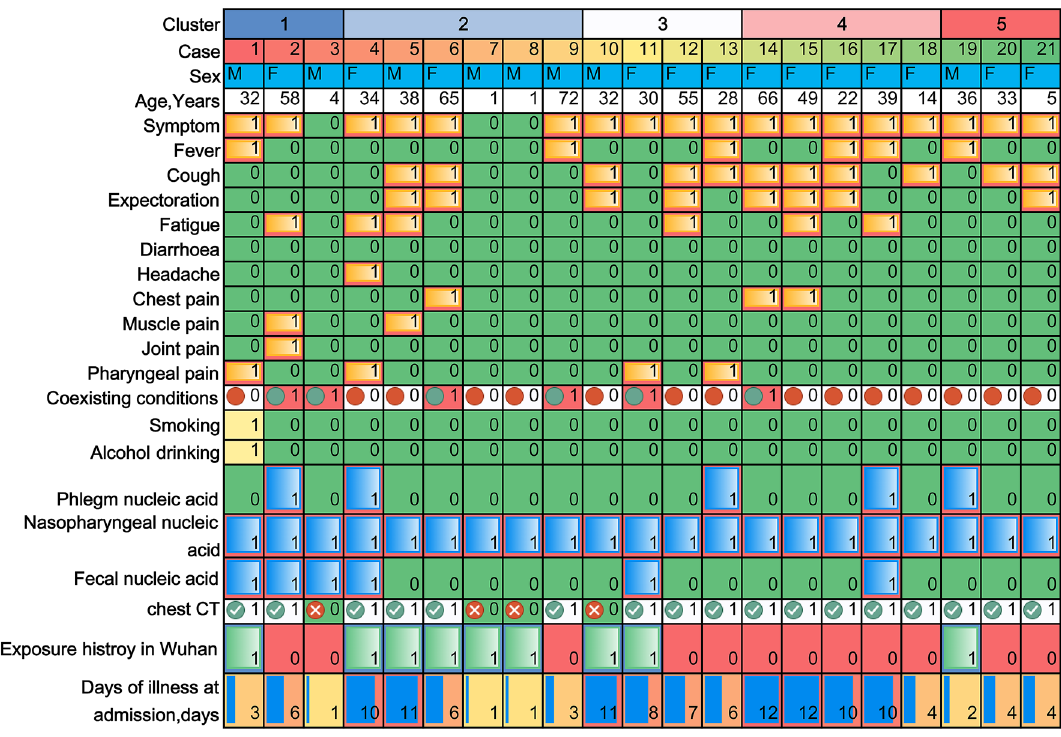
Figure 2. The epidemiology and basic characteristics for all the patients of the five family